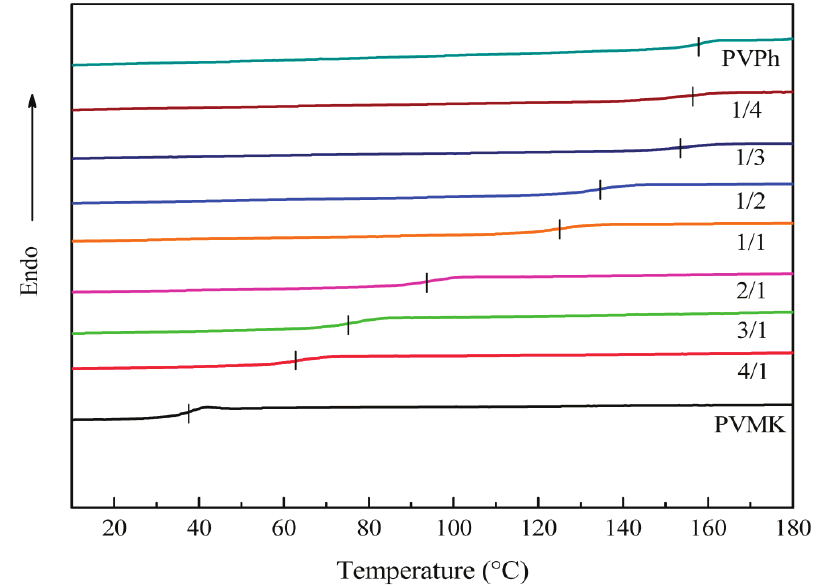
Figure 1. DSC thermograms of poly(4-vinylphenol) (PVPh)/poly(vinyl methyl ketone) (PVMK)